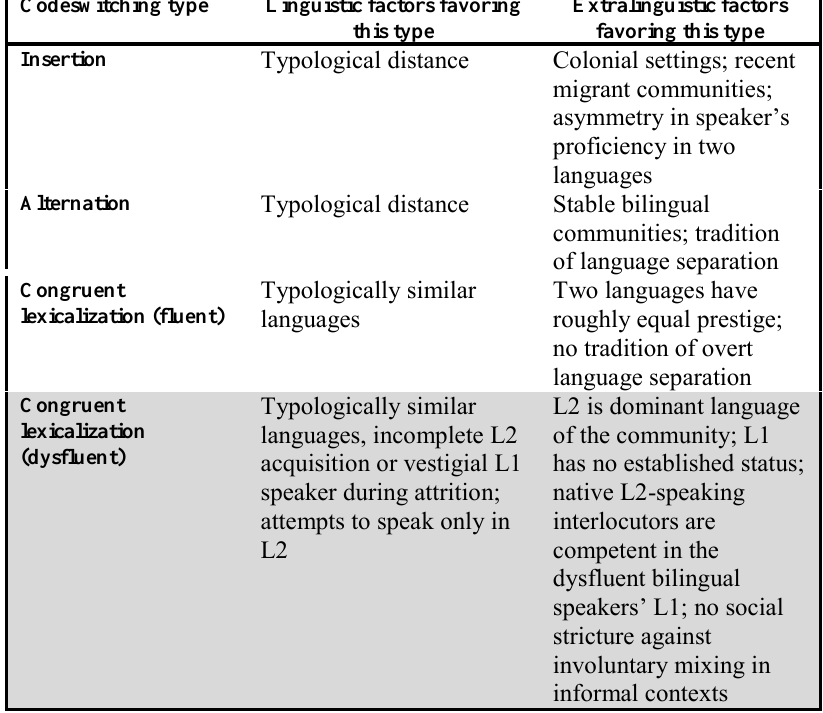
Table 5: Revised code-switching